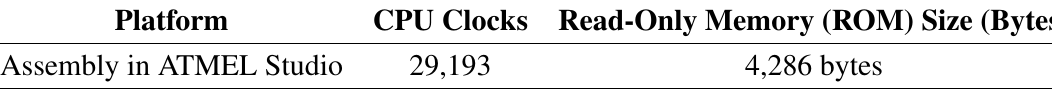
Table 10. Performance analysis of